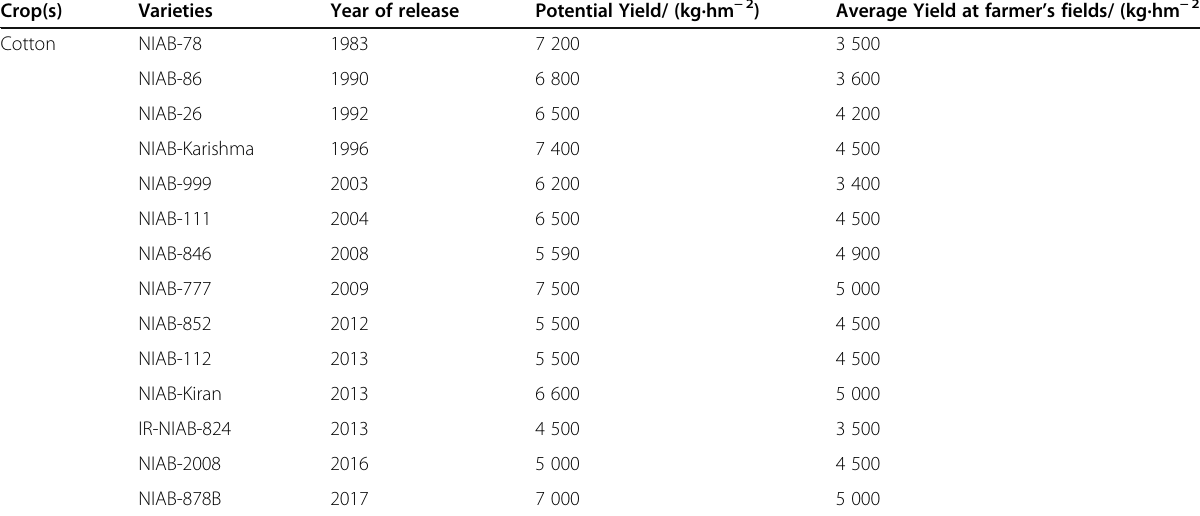
Table 1 The cotton varieties ( Gossypium hirsutum ) developed through mutation breeding Crop(s) Varieties